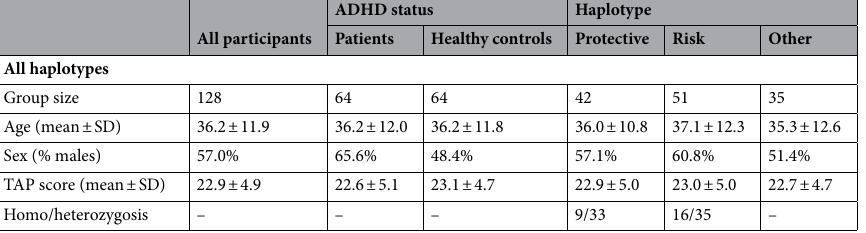
Table 1. Description of the sample. TAP: “ Test de Acentuación de Palabras ” (an indicator of premorbid